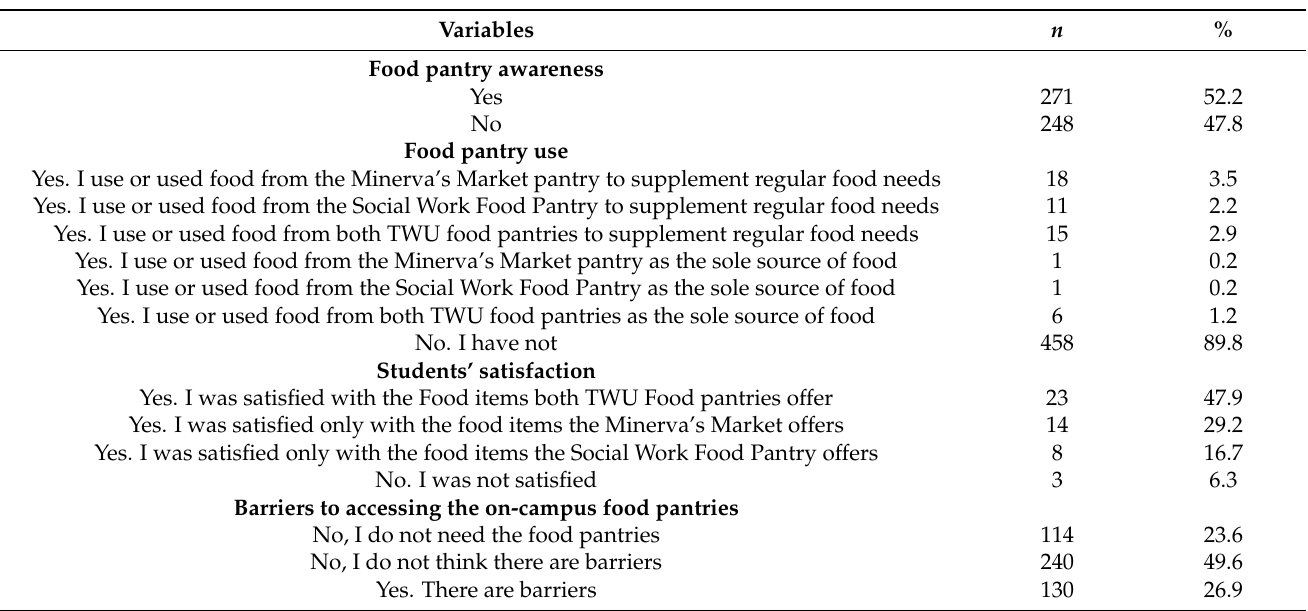
Table 3. Description of Students’ On-Campus Food Pantries Awareness, Use of, Satisfaction with, and Perceived Barriers to